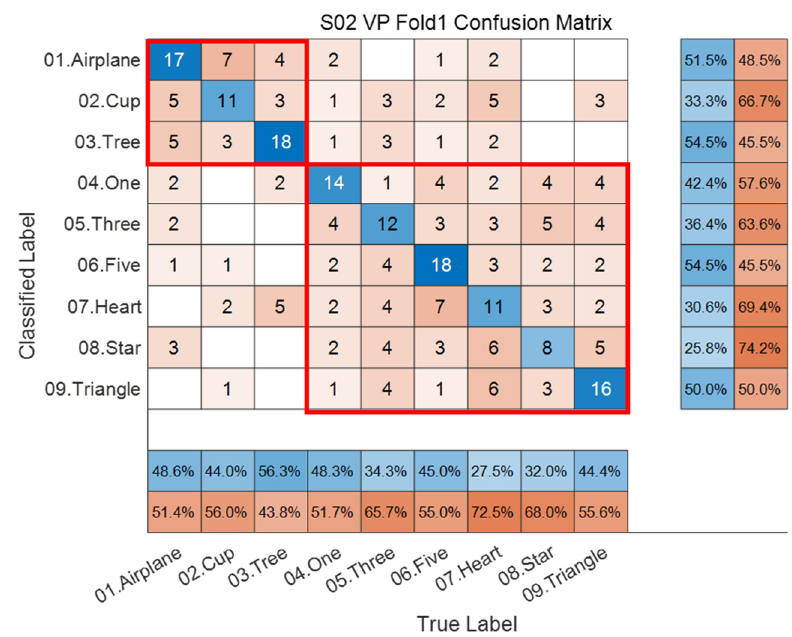
Figure 7. Exemplary confusion matrix of MultiRocket classifier for S02 in VP.